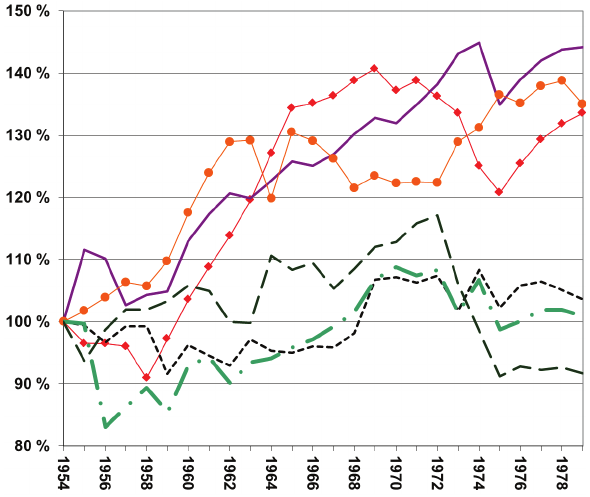
Fig. 9. A comparison of domesticated reindeer populations in the eastern and western parts of the Russian tundra in the period from 1954 to 1979. The baseline year is 1954. The eastern tundra is defined as Chukotka ( ―♦ ), north-east of Iakutia ( ― ), and north-west of Iakutia( ―● ). The western tundra is defined as the Kanin/Timan tundra ( ), Nenets okrug ( ), Kola peninsula ( ). During this period, the reindeer population in the eastern part of Russian tundra was increased slightly while numbers in the western tundra remained